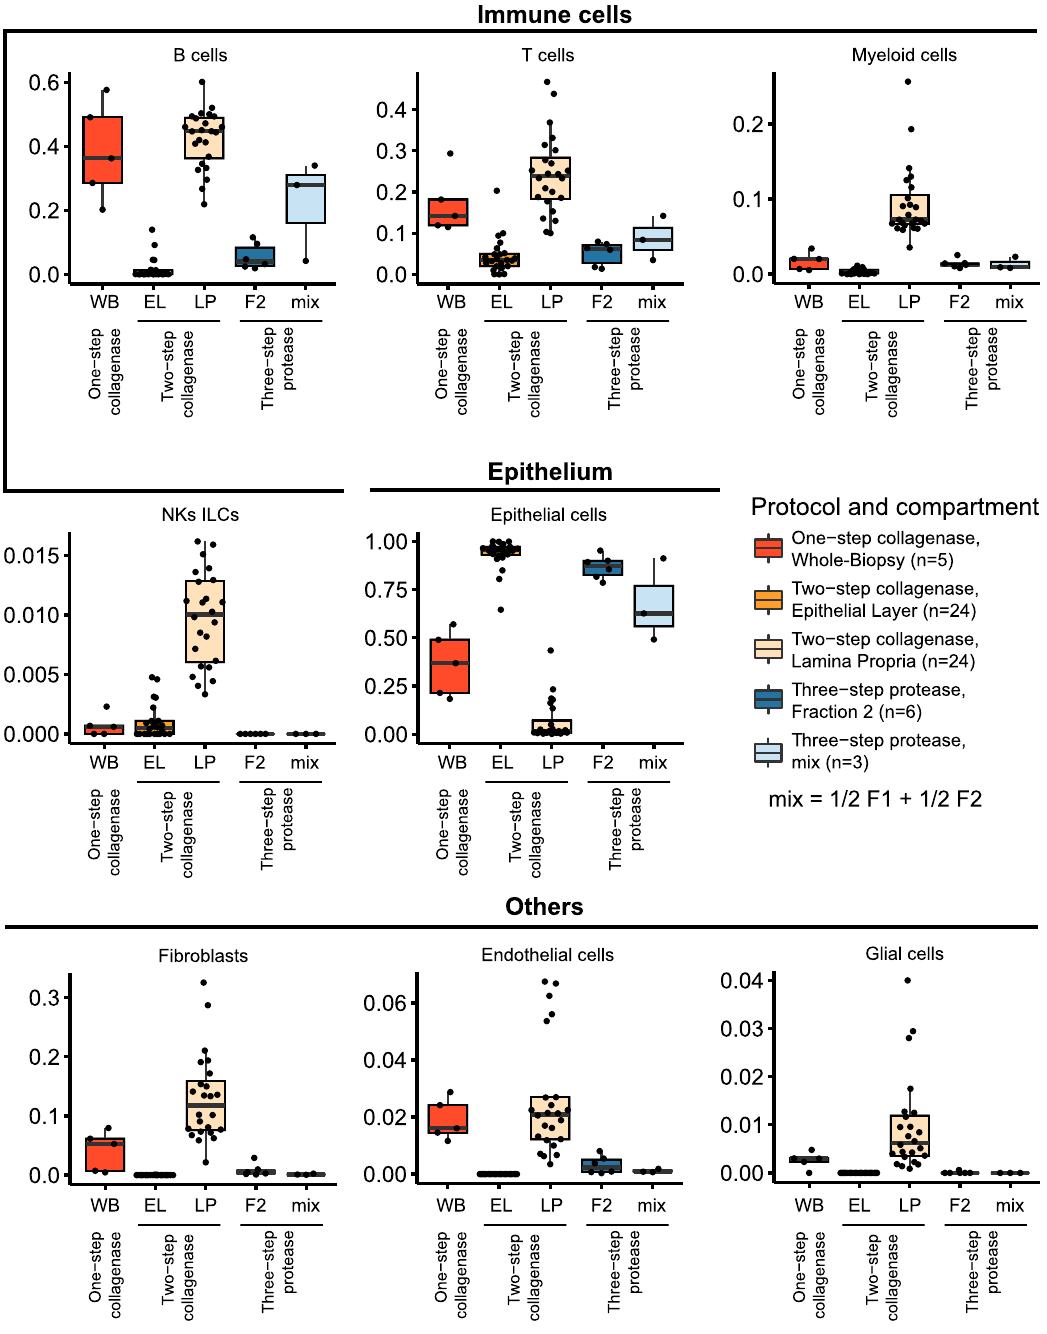
Figure 4. Differences in cell type proportions recovered in each protocol using scRNA-seq. Boxplots of cell type proportions characterized by scRNA-seq. The resulting cell type composition of samples was tested across the protocols and compartments (Wilcoxon rank sum test with Holm’s correction for multiple testing, Suppl. Table 6). Compartments and dissociation protocols are indicated in the x-axis. Sample size is depicted in the legend of the plot. WB, whole biopsy; EL, epithelial layer; LP, lamina propria; F1, fraction 1; F2, fraction